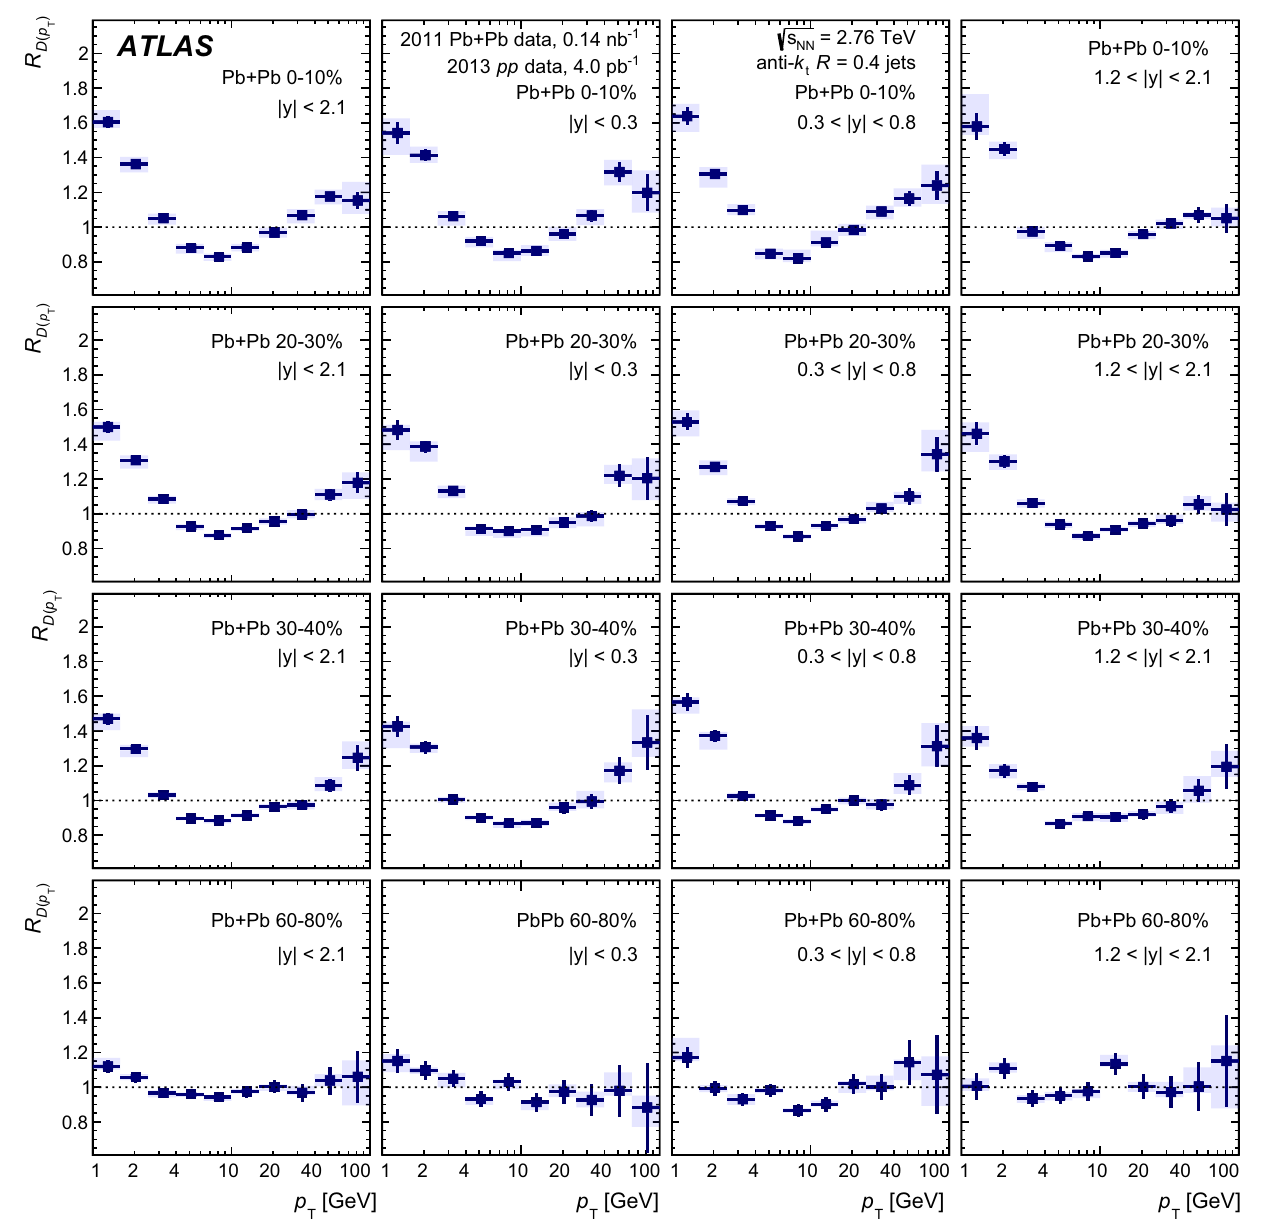
Fig. 4 The ratio R D ( p of unfolded D ( p T ) distributions measured in T ) heavy-ion collisions to unfolded D ( p T ) distributions measured in pp distributions were evaluated in four different collisions. The R D ( p T ) centrality bins ( rows ) and four different selections in jet rapidity of jets